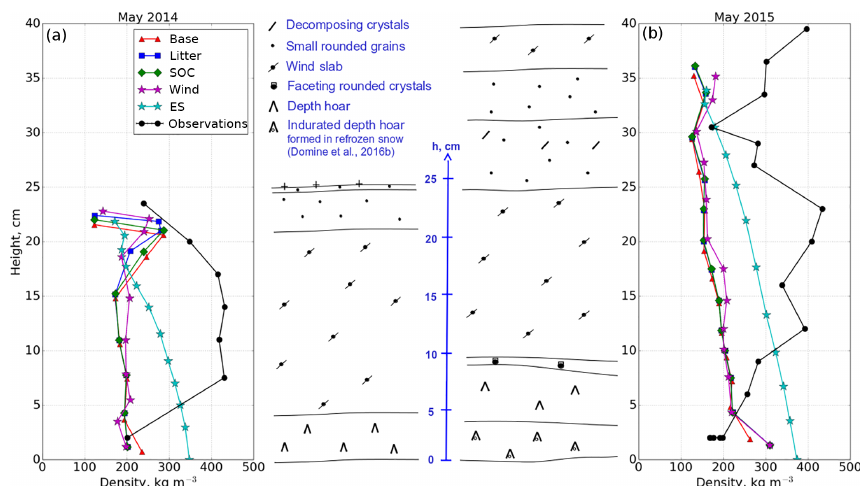
Figure 3. Stratigraphies and vertical profiles of density measured on 14 May 2014 (a) and 12 May 2015 (b) , and simulated densities on 14 May 2014 and 6 May